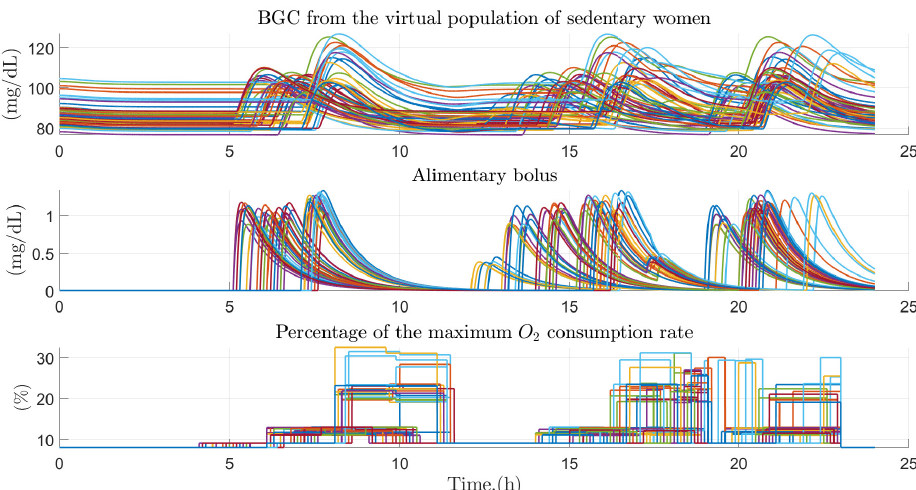
Figure 10. Effect of primary and secondary factors on the virtual population of sedentary women. Effect of diet and physical activity on glucose concentration in a virtual population of 50 women with sedentary